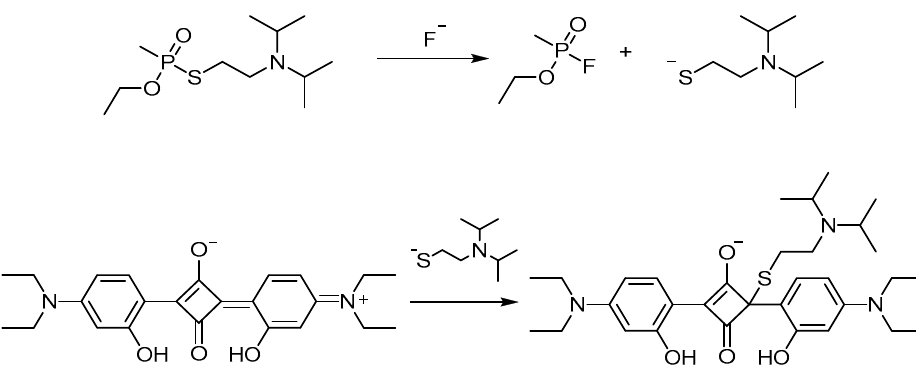
Scheme 2. The proposed mechanism of MS in the colorimetric detection of VX.